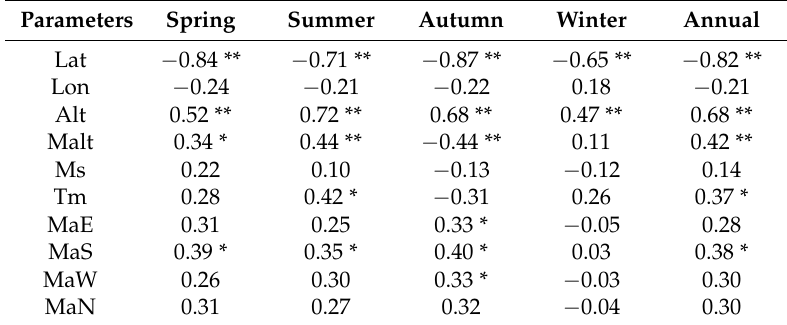
Table 4. Same as Table 2, but for stations with an elevation above 1700 m.